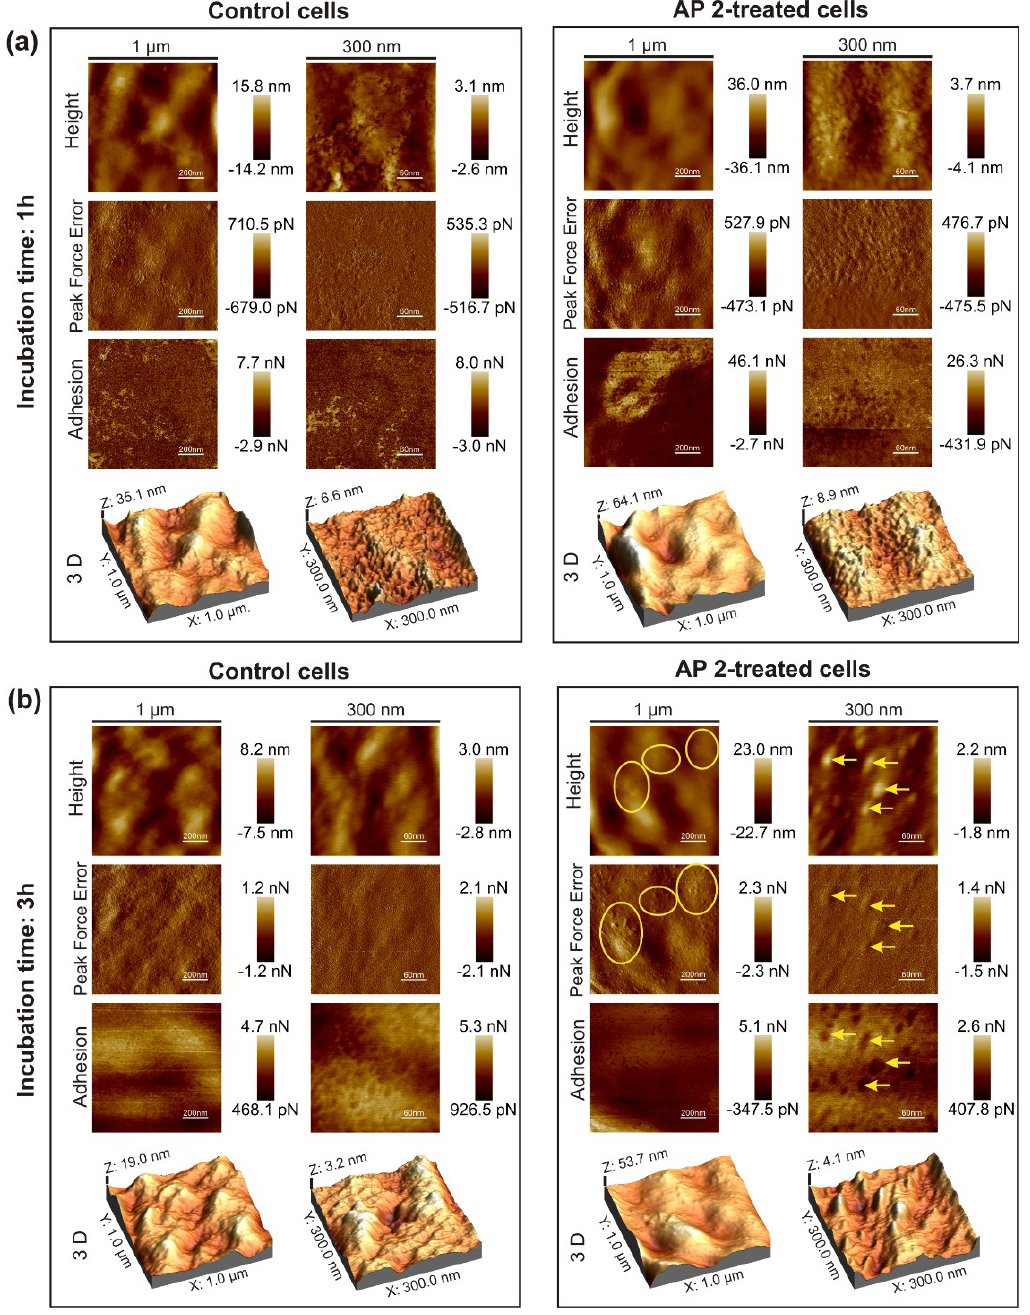
Figure 3. Effect of AP2 on C. albicans cell surface topography. The log-phase cells were incubated without (control) or in the presence of 5 μM AP2 at 37 °C for 1 h ( a ) and 3 h ( b ). The cells were then subjected to imaging by AFM. The height, “peak force error”, adhesion, and three-dimensional (3D) images are presented. The imaged areas of 1 μm × 1 μm (left panels) and 300 nm × 300 nm (right panels) are demonstrated. The yellow ellipses and yellow arrows indicate regions decorated with small clods and the clods, respectively.